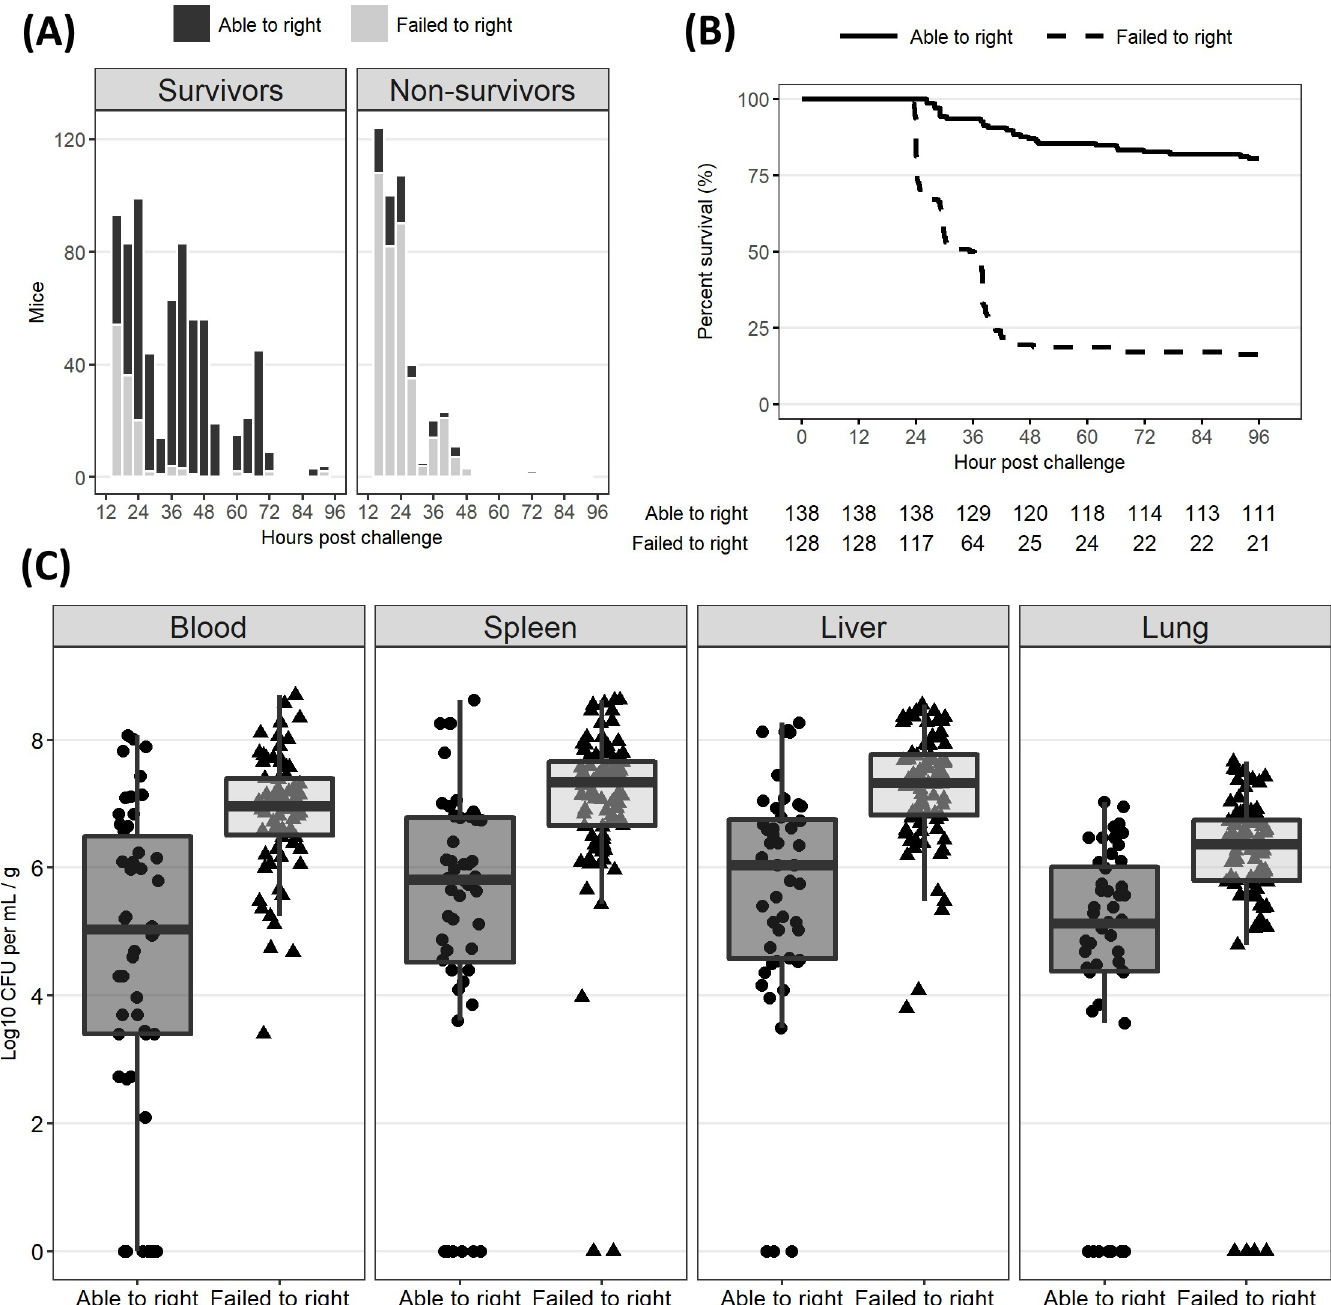
Fig 1. Righting reflex at 24 HPC is an excellent discriminator of survival and bacterial load. Righting reflex of neonatal mice (DOL 7–8) challenged IP with cecal slurry at an LD50. (A) Ability to right at different hours post challenge (HPC) in survivors and non-survivors. (B) Survival curve of mice split by righting reflex at 24 HPC. Mice which were able to right themselves at 24 hours were significantly more likely to survive the cecal slurry challenge than mice which failed to right (log-rank test, p < 0.001). (C) Bacterial load split by righting reflex at time of sacrifice, 24 HPC. Mice which were able to right had significantly lower bacterial load in blood and all measured organ tissues (two-sided Wilcoxon rank-sum tests with Bonferroni correction, p < 0.001).